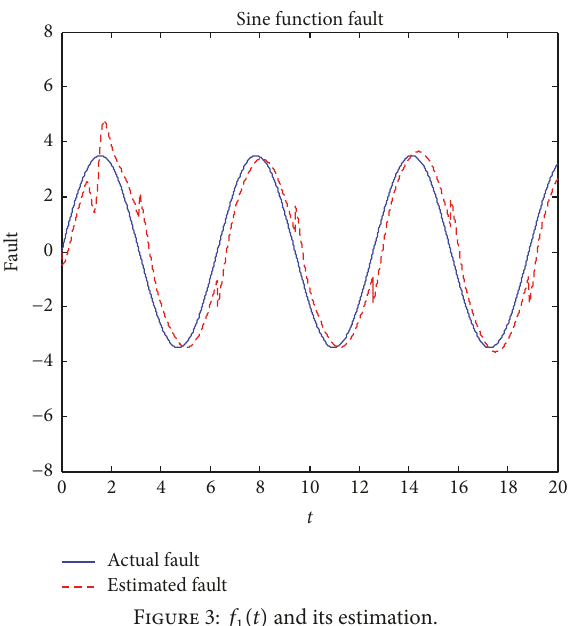
Figure 3: 𝑓 1 (𝑡) and its estimation.